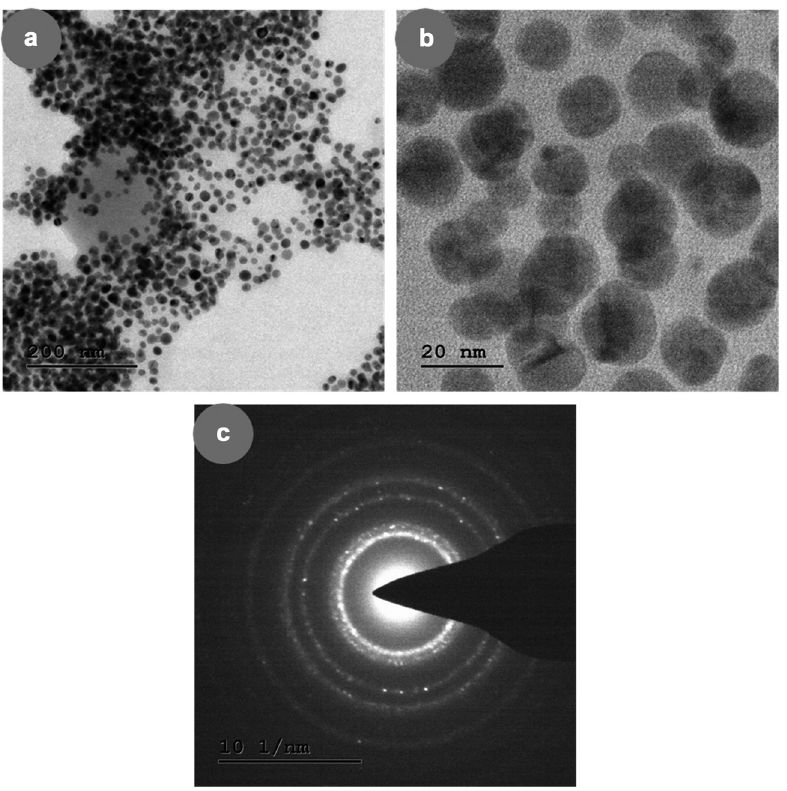
Figure 3: ( a and b ) TEM images; ( c ) SAED pattern of synthesized Ar -